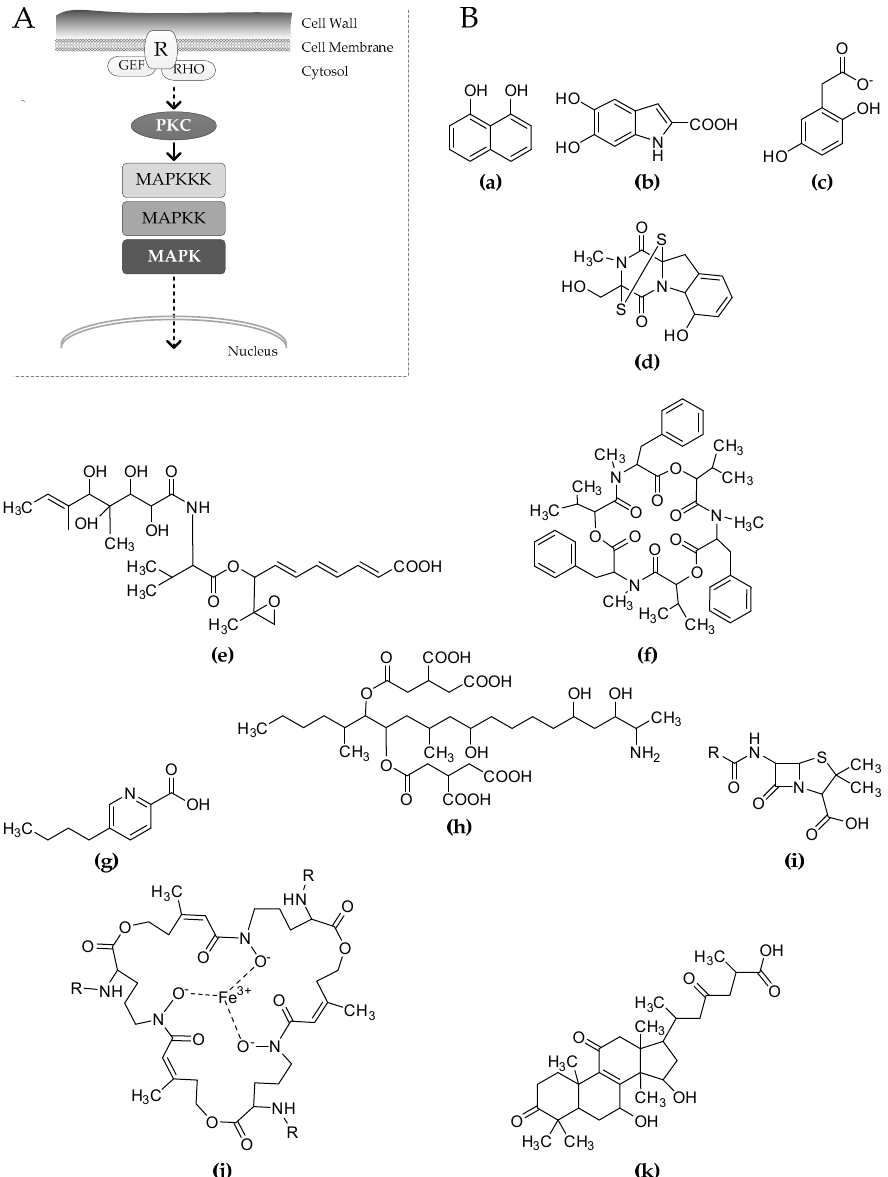
Figure 1. ( A ) Schematic representation of the cell wall integrity (CWI) signaling pathway in fungi. Stress signals from the cell wall are sensed by receptors (R), which are strongly associated with GTPases such as guanidine nucleotide exchange factors (GEFs) and Ras homologs (RHOs). The phosphorylation cascade begins through the protein kinase C (PKC) that activates by phosphorylation of the MAPK module. After being phosphorylated, the MAPK moves to the nucleus, promoting gene transcription through the activation of specific transcriptional regulators. ( B ) Secondary metabolites differentially regulated consequent to the inhibition of the CWI signaling. 1,8-dihydroxynaphthalene ( a ), homogentisate ( b ), and dihydroxyindol ( c ) are known precursors of 1,8-dihydroxynaphthalene (DHN)-melanin, L -Dopa melanin, and pyomelanin respectively. Other represented molecules are: gliotoxin ( d ), ACT toxin ( e ), beauvericin ( f ), fusaric acid ( g ), fumonisin B1 ( h ), penicillin ( i ), triacetylfusarinine C ( j ), and ganoderic acid ( k ).